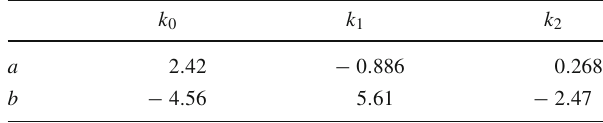
Table 3 The energy dependence of the CIC parameters (Eq. (6)) are given below